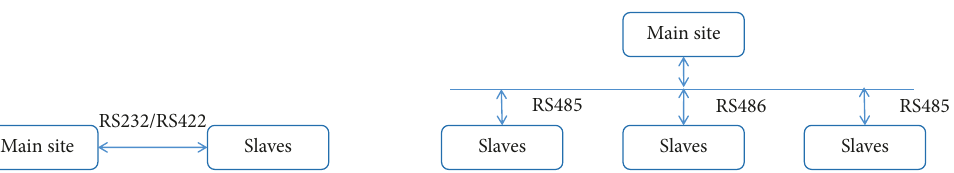
Figure 12: Comparison of Modbus protocol point-to-point communication and multipoint communication.